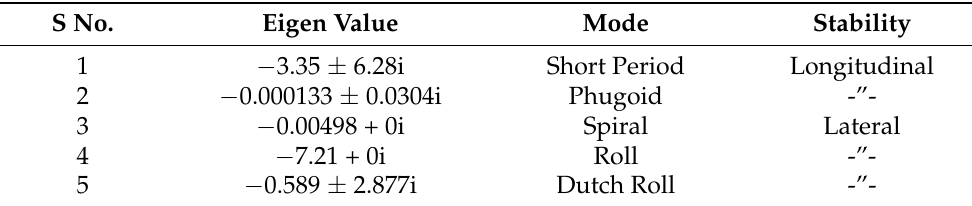
Table 3. Eigenvalues obtained from XFLR for the Boeing 747’s dynamic stability analysis. S